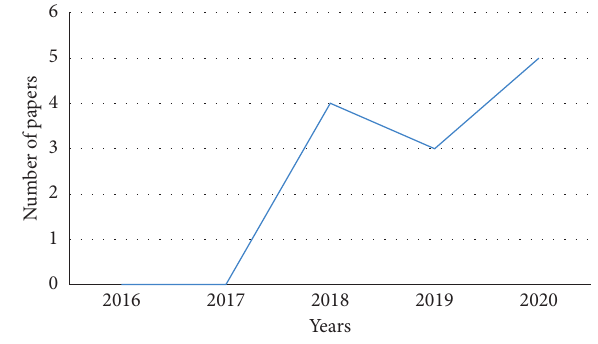
Figure 3: Papers published in the mentioned years.